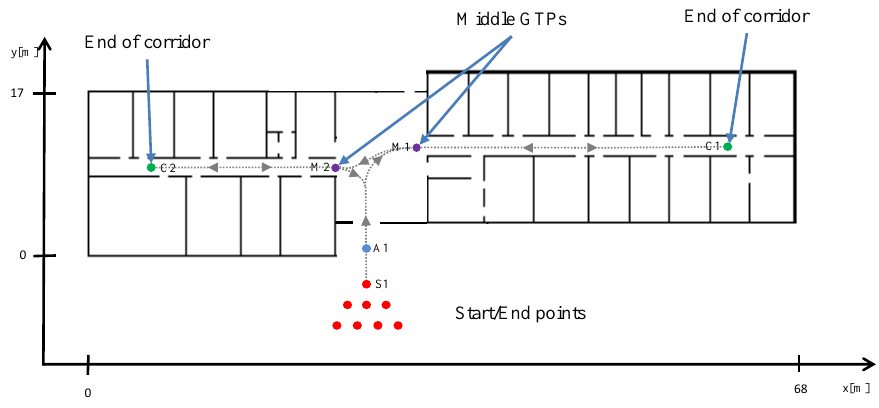
Figure 3. Building layout of the ground floor of our office building. The ground truth points (GTP) used are marked in different colors. Several starting points—marked in red—are used to emulate a group of pedestrians or emergency forces entering the building. The dotted arrows/lines represent the starting/walking